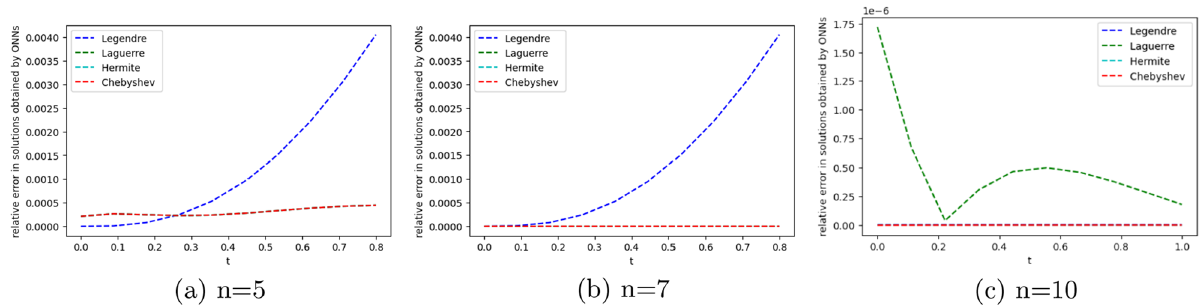
Figure 14. Error graph of z 1 ( t ) for different orthogonal neural networks with different numbers of neurons for Example